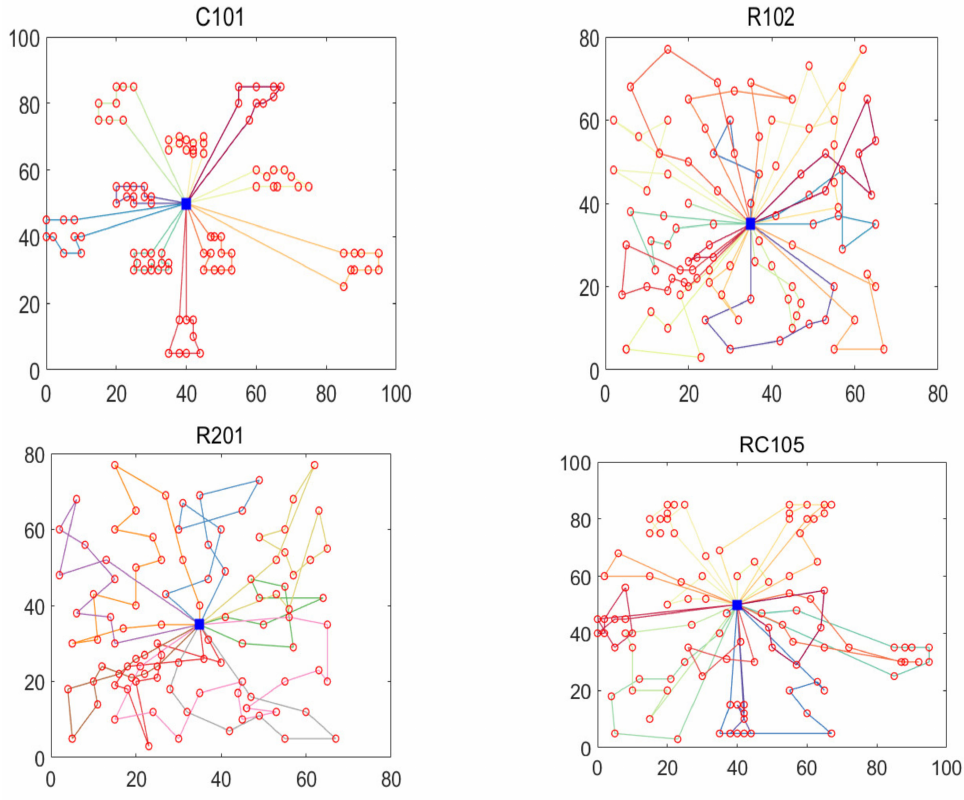
Figure 9. The optimal routes for four datasets, different colored lines denote the different routes, and the red circles represent the